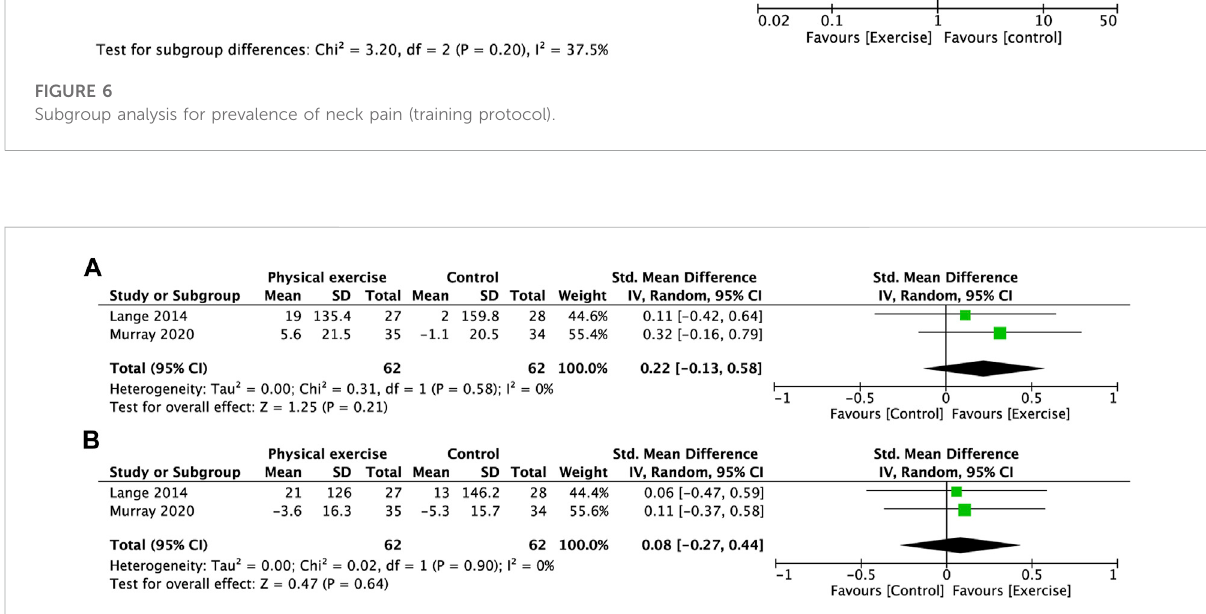
FIGURE 7 Forest plot comparing MVIC of the shoulder in the physical exercise and control groups. (A) Right elevation. (B) Left elevation. MVIC, maximal voluntary isometric